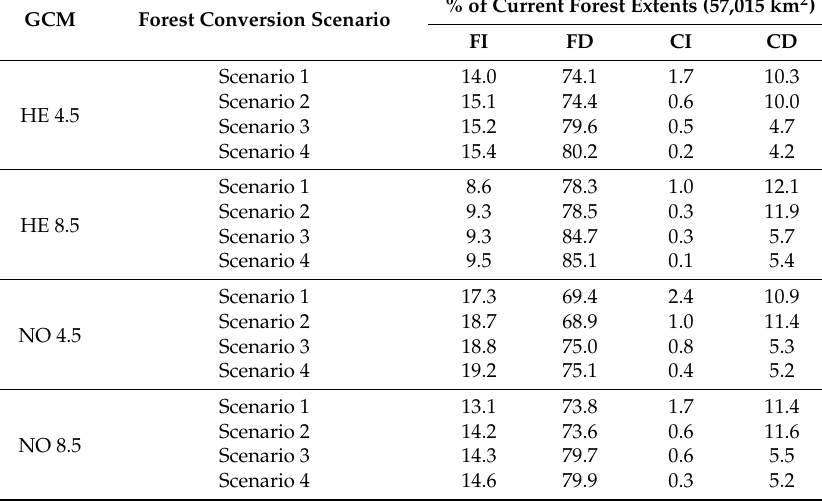
Table 2. Proportions of current forest extents of four forest categories (FI: forest preserved, and species richness increase, FD: forest preserved, but species richness decrease, CI: converted to other land use classes, but species richness increase, and CD: converted to other land use classes, and species richness decrease) in 16 case